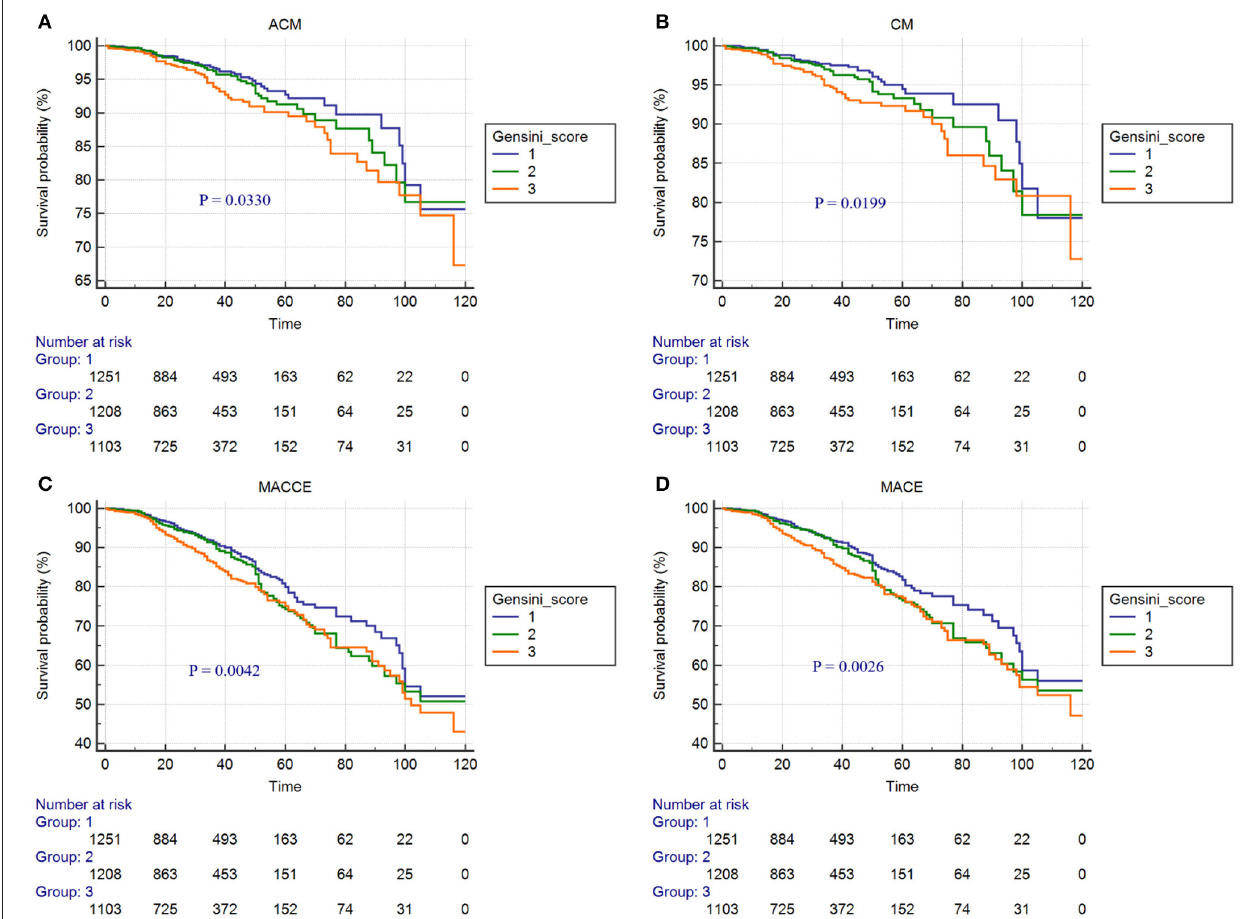
FIGURE 3 | Cumulative Kaplan-Meier estimates of the time to the first adjudicated occurrence of primary endpoints and secondary endpoints: (A) ACM; (B) CM; (C) MACCEs; (D) MACEs. (In the 3,562 CAD patients without